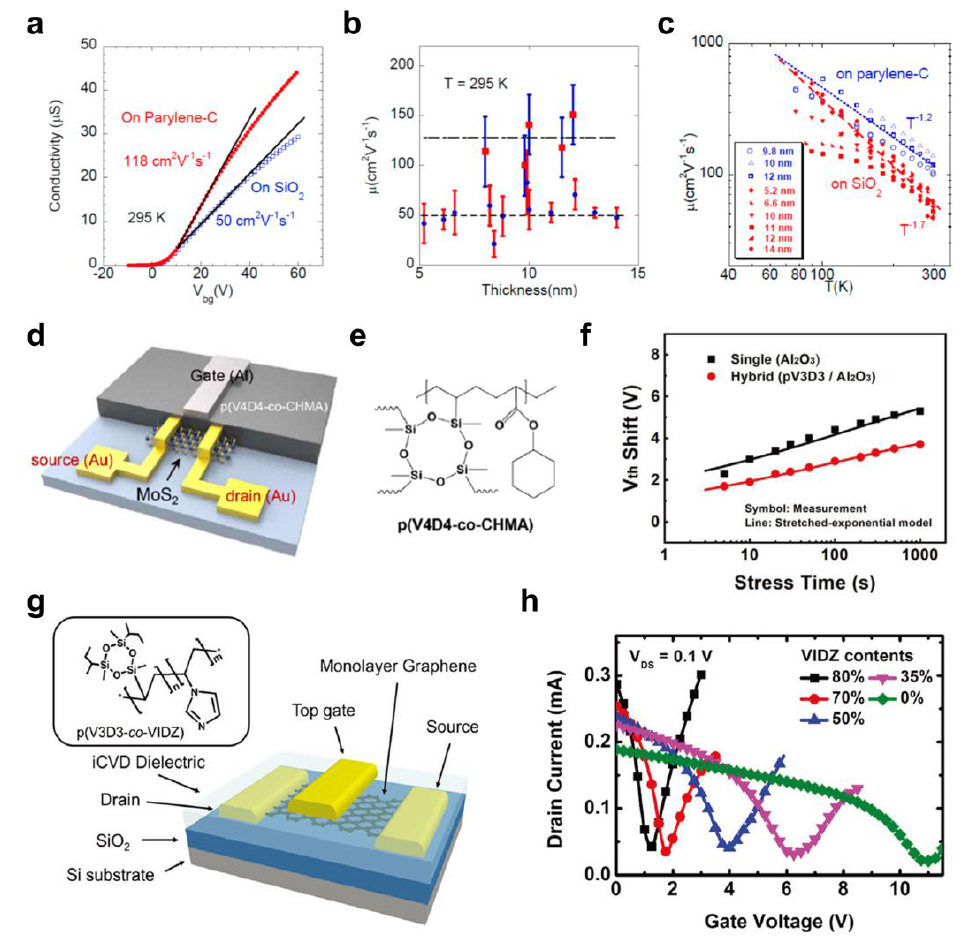
Figure 4. ( a ) Conductance− V G curves, ( b ) μ in relation to the MoS 2 thickness, and ( c ) the change in μ in relation to the temperature for 2D MoS 2 FETs fabricated with a parylene interfacial layer compared to those without a parylene layer (on SiO 2 ) [96]. Copyright © 2014, American Chemical Society. ( d ) Schematic illustration of the top − gate, 2D MoS 2 FET based on the iCVD dielectric and ( e ) the chemical structure of P(V4D4 − co − CHMA) [106]. Copyright © 2018, American Chemical Society. ( f ) The V T shift with the stress time for the 2D MoS 2 FETs with the hybrid dielectric (PV3D3/Al 2 O 3 ) compared to those without the PV3D3 dielectric in NBIS measurements [107]. Copyright © 2021, John Wiley and Sons. ( g ) Schematic diagram of the device structure for a graphene FET with iCVD-based P(V3D3 − co − VIDZ). ( h ) Change in the I D − V G curves with the VIDZ contents in P(V3D3 − co − VIDZ) dielectric layers [108]. Copyright © 2018, John Wiley and Sons.